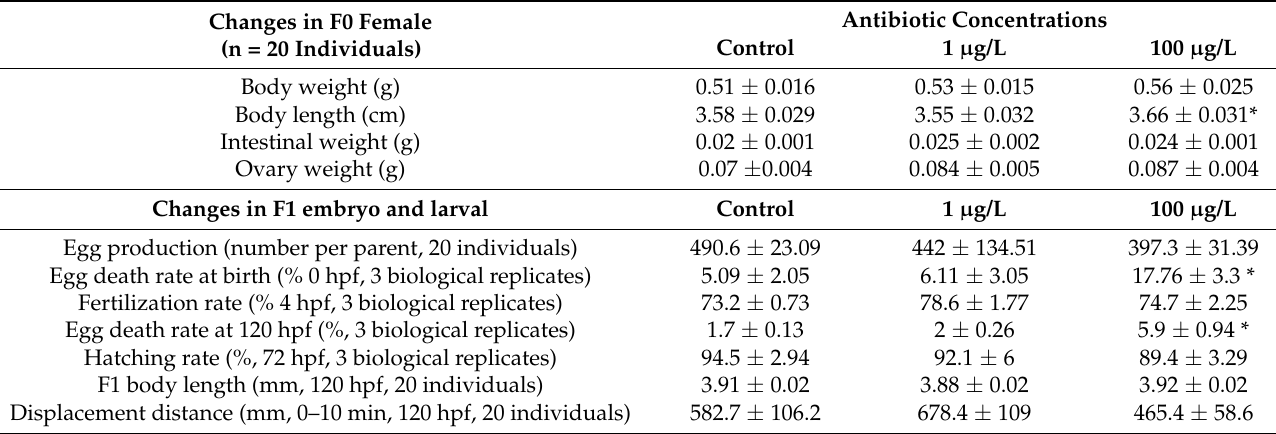
Figure 3. Histopathological changes in adult zebrafish eye ( A ), brain ( B ), hepatic ( C ) and spleen ( D ) tissues after exposure to a series of DKA concentrations. Arrows in Figure 2A indicate photoreceptor cell cysts and intercellular vacuoles; in Figure 2B the “a arrow” shows the decrease in neuron number, “b arrow” shows ventriculomegaly and “c arrow” shows glial cell proliferation and the formation of a glial scar; in Figure 2C the “a arrow” indicates reduced, swollen and vague hepatocytes, “b arrow” shows hepatic parenchyma vacuolar degeneration and “c arrow” denotes blood accumulation and clot formation; in Figure 2D the “d arrow” shows metachromatic granules. Histopathological observations on these organs were performed with hematoxylin and eosin (HE) staining using a standard protocol. The photographs of the tissues were taken when 3 biological replicates showed a high degree of uniformity. [113,115]. Table 2. Morphological measurements for F0 female and F1 embryo and larval zebrafish following maternal antibiotic mixture treatment for 4 weeks. All data are expressed as mean ± SD.